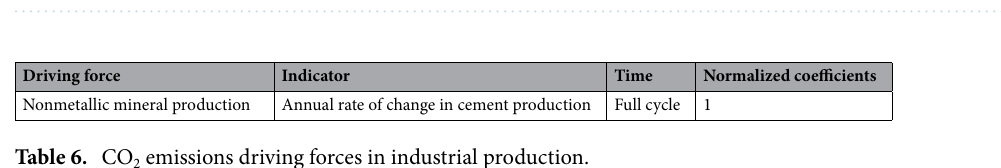
Table 5. CO 2 emissions driving forces in fuel combustion in other industries. (Data source: calculated fitting coefficients).